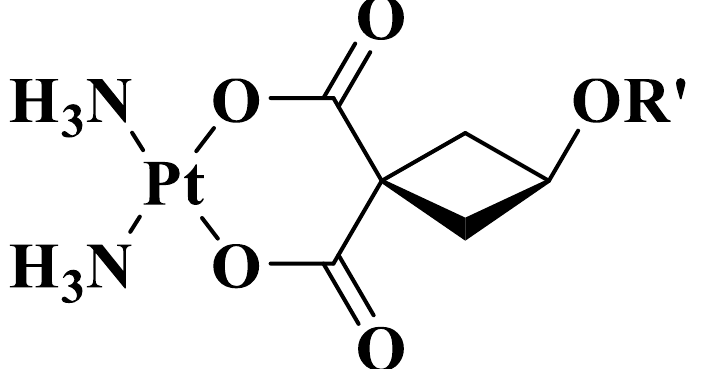
Figure 6. Structure of carboplatin moiety. Table 1. Structures and properties of Kpt ligands.